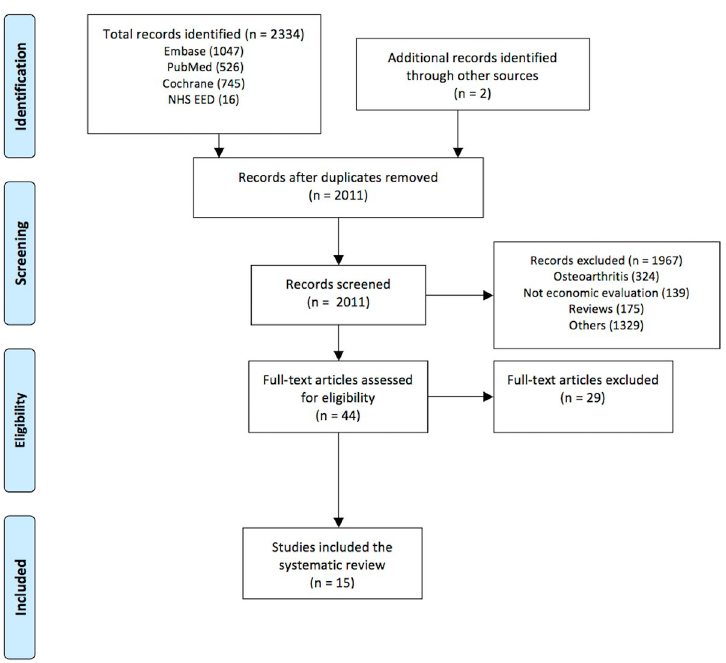
Fig 1. Preferred Reporting Items for Systematic Reviews and Meta-Analyses (PRISMA) flowchart. Numbers in parenthesis in the box indicate the number of studies after each phase. Number in parenthesis in the lowermost box indicates the number of studies included in the review. Fifteen papers were retrained as they met the inclusion and exclusion criteria[26–40].